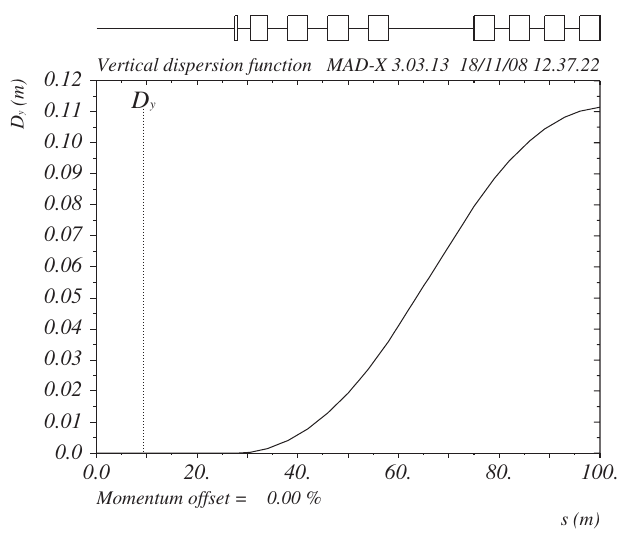
FIG. 14. Dispersion function along the first 100 m of the CLIC post-collision line, obtained with MAD-X [12].